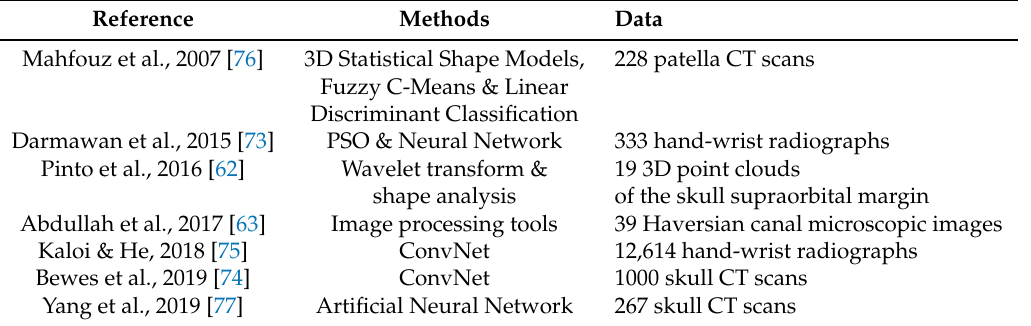
Table 1. An overview of the literature on artificial intelligence (AI)-based approaches for sex estimation from skeletal data. References are ordered according to their publication